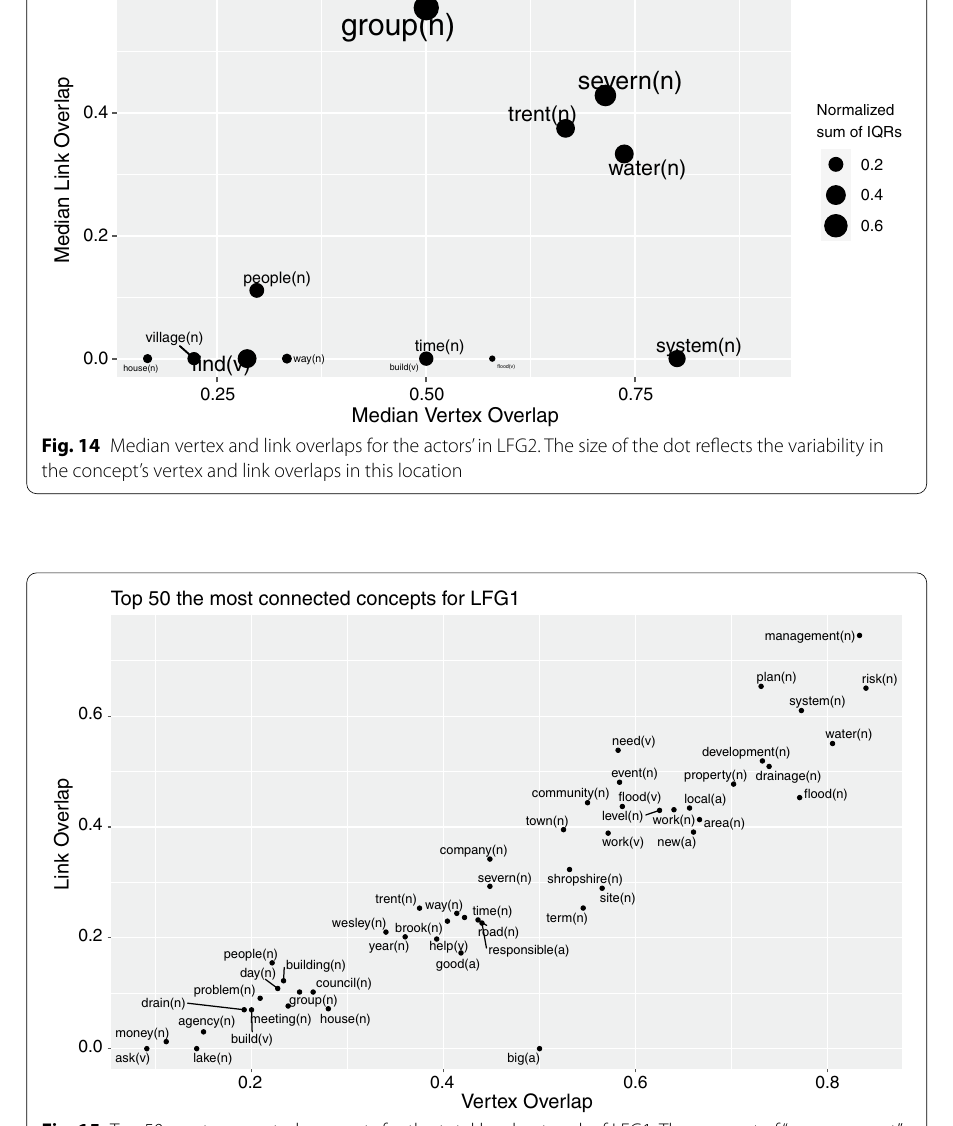
Fig. 15 Top 50 most connected concepts for the total local network of LFG1. The concept of “management” yields the highest vertex and link